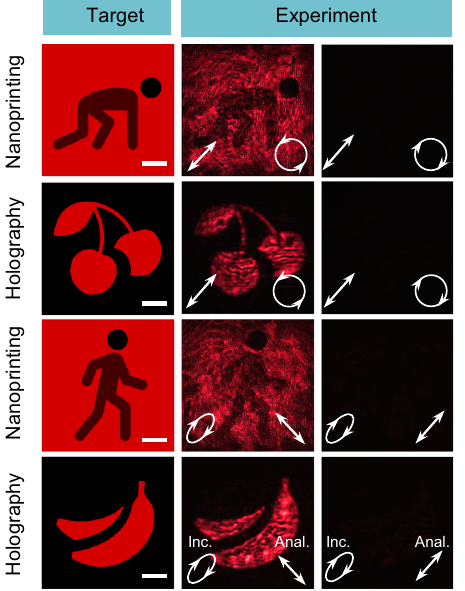
Fig. 3 | Experiment demonstration of the independent amplitude and phase control of arbitrary set of two polarizations based on Jones matrix with eight DOFs. The fi gure shows the target and measured nanoprintings and holographic images. The incident and analyzed polarizations are indicated in lower left and lower right corners of each panel. Scale bar: 50 μ